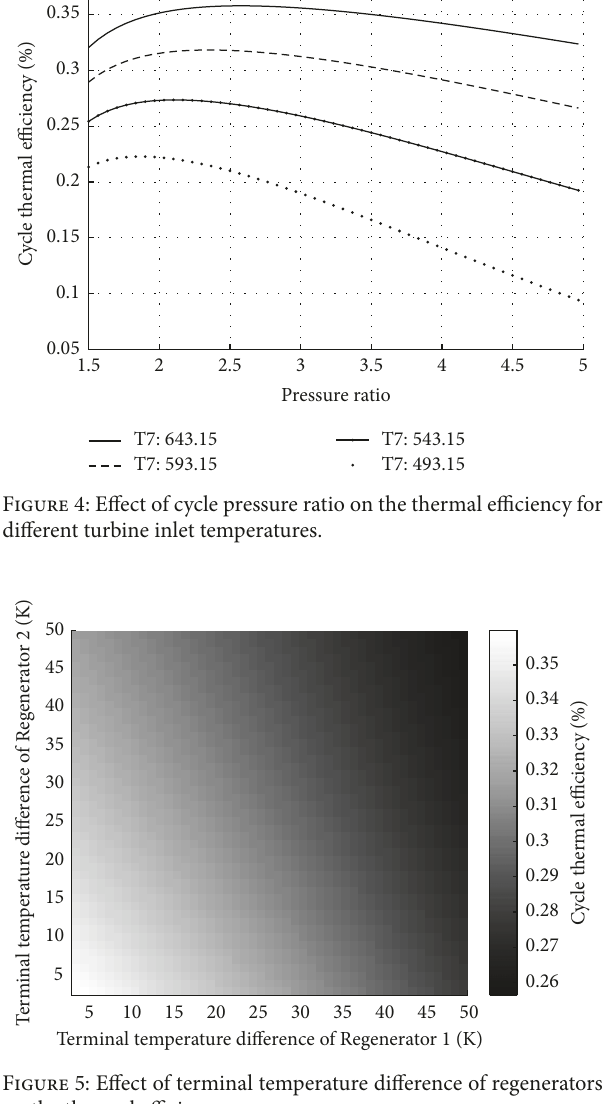
Figure 5: Effect of terminal temperature difference of regenerators on the thermal efficiency.